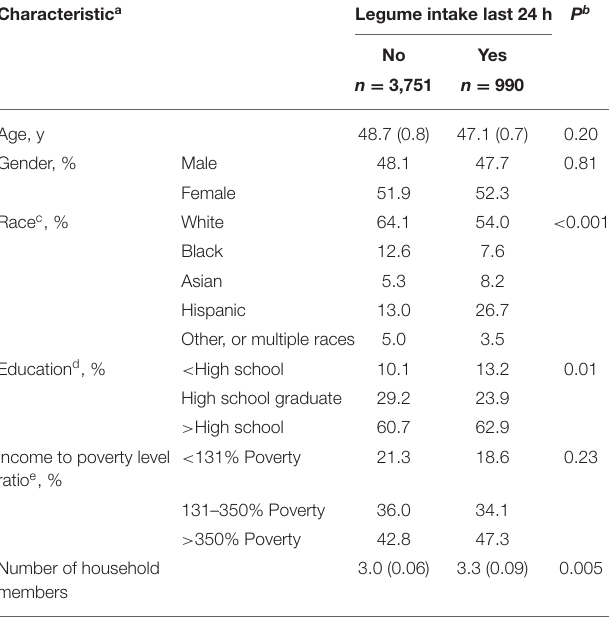
TABLE 2 | Legume intake among 990 adults in NHANES who reported consuming legumes in the last 24 h. Characteristic a Legume